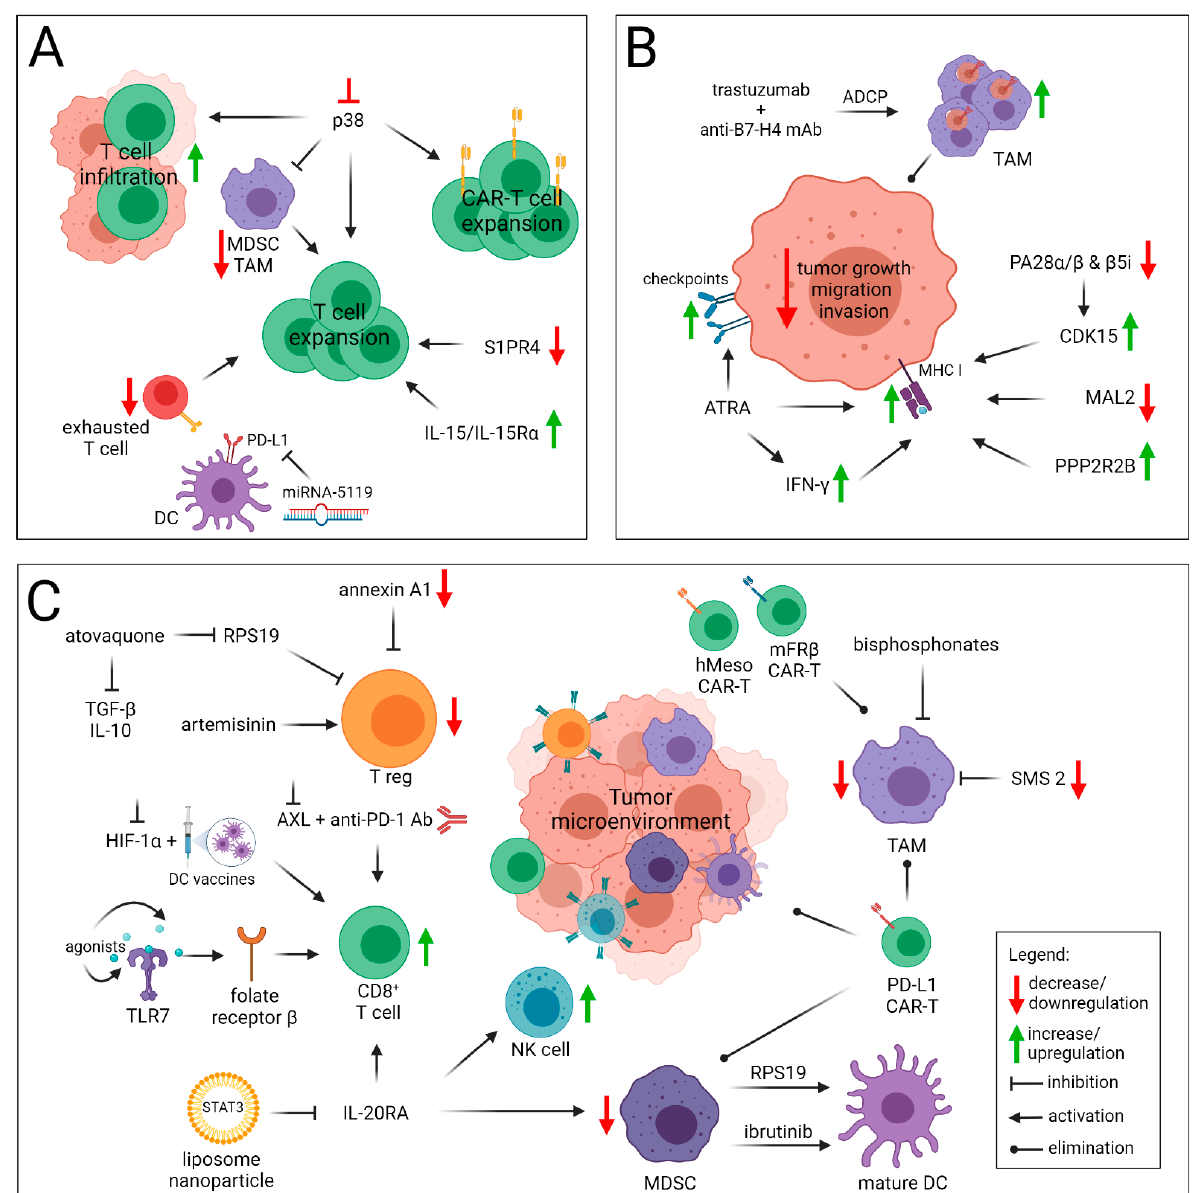
Figure 3. Mechanisms and countermeasures of immunotherapy resistance in breast cancer. Interventions promoting ( A ) expansion and trafficking of T cells within the tumor, ( B ) antigen presentation or target molecule expression, ( C ) limiting the immunosuppressive influence of tumor microenvironment. Depicted actions comprise the molecular modification of the immune cells, administration of stimulatory or inhibitory drugs or combined approaches. The mechanisms presented in the figure are thoroughly described in the text. p38—p38 kinase, S1PR4—sphingosine-1 phosphate receptor 4, CAR—chimeric antigen receptor, IL-15/IL-15R α —heterodimeric complex of interleukin-15 and interleukin-15 receptor α ,